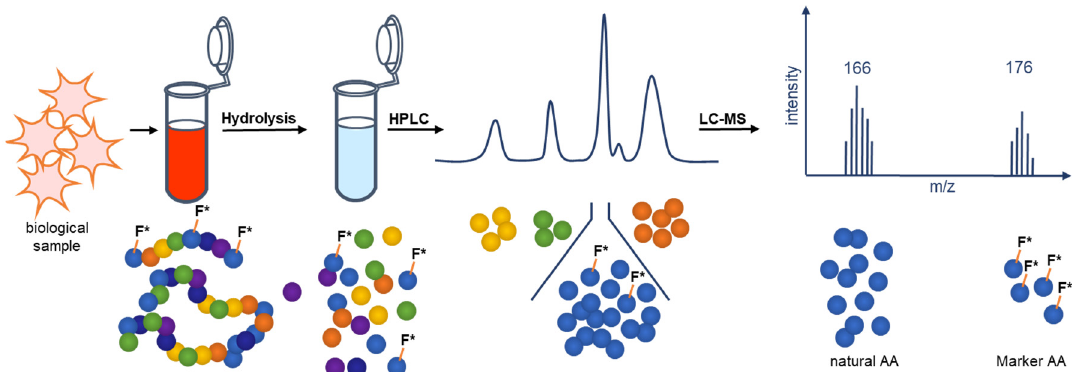
Figure 2. Schematic presentation of the principle of the novel mass spectrometric quantification method of Pep19-2.5 in biological samples. The quantification of Pep19-2.5 is possible after acidic hydrolysis and LC-MS analysis by implementing marker amino acids ( 13 C 9 , 15 N 1 phenylalanine).